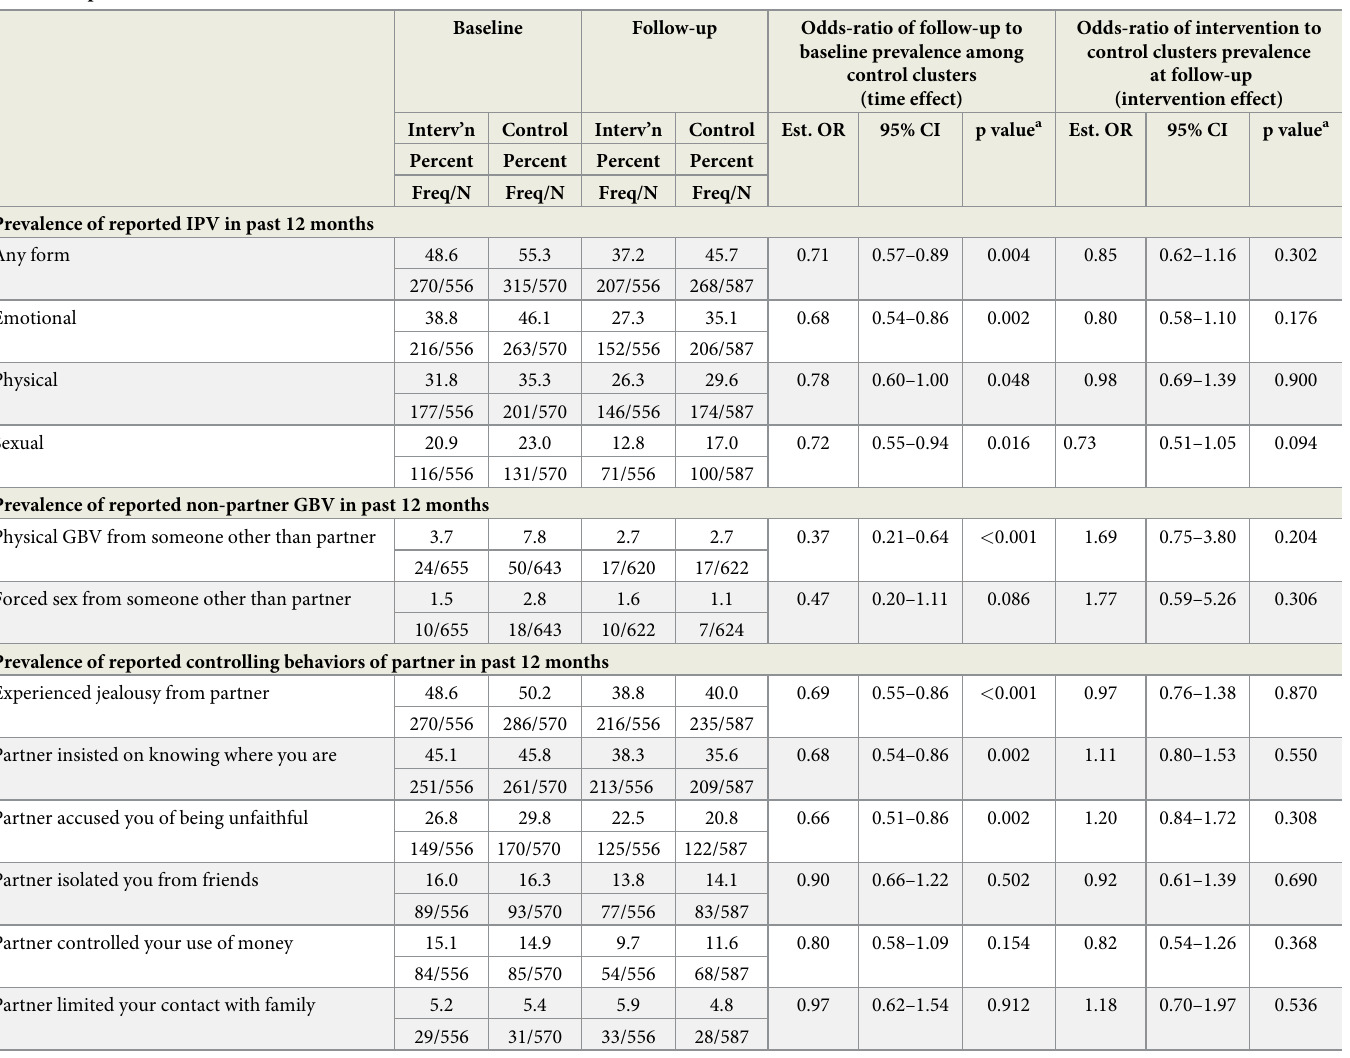
Table 5. Experience of IPV and other forms of